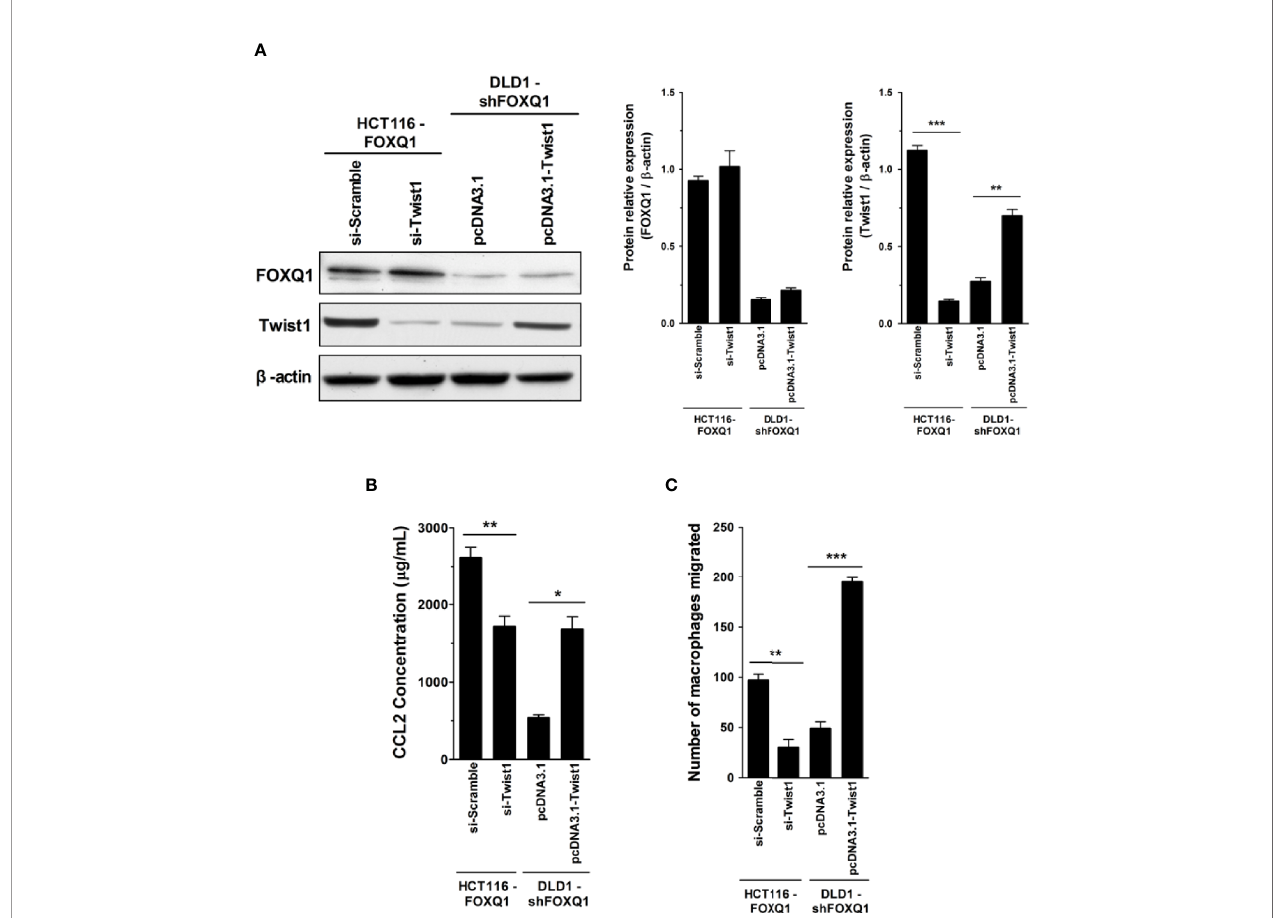
FIGURE 6 | Twist1 is essential for FOXQ1-mediated macrophage recruitment in CRC. (A) HCT116-FOXQ1 cells were co-transfected either with si-Twist1 or si- Scramble; DLD1-shFOXQ1 was co-transfected either with pcDNA3.1-Twist1 or pcDNA3.1. After 48 h culture, Western blot analysis was performed for detection of FOXQ1 and Twist1 proteins. (B) Twist1 knockdown abolished FOXQ1-mediated CCL2 upregulation, whereas upregulation of Twist1 rescued the decreased secretion of CCL2 induced by FOXQ1 knockdown. ELISA analysis of CCL2 secretion was detected in CM. (C) Twist1 knockdown eliminated the FOXQ1- induced inhibition of macrophage recruitment, whereas upregulation of Twist1 rescued the decreased macrophage in fi ltration ability induced by FOXQ1. Chemotactic properties of CCL2 secreted by CRC cells on macrophage in fi ltration were determined by Transwell assay. * P <0.05, ** P <0.01, *** P <0.001 signi fi es a signi fi cant difference between the indicated groups (two-tailed, unpaired Student ’ s t -test). Bars represent mean ± S.E. of three independent